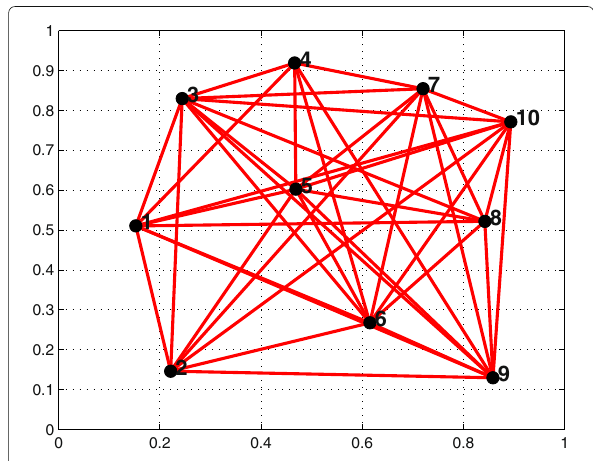
Fig. 2 Network topology for the simulation results in Section 5.1